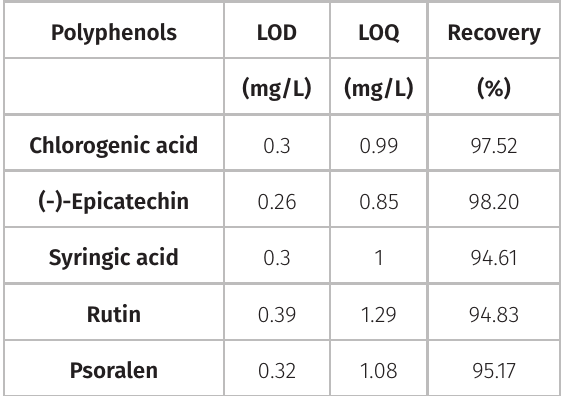
Table I. LOD, LOQ values and recovery of the polyphenols from the fig seeds studied by HPLC (n =